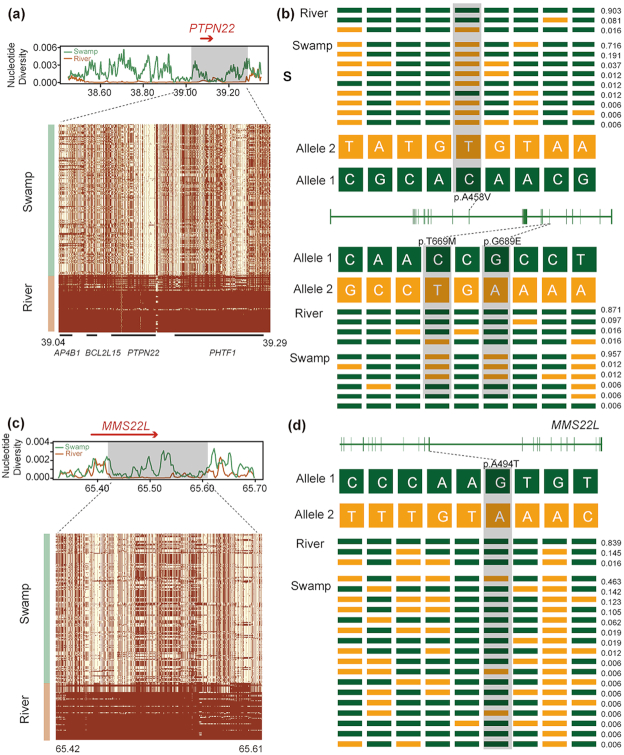
Signatures of selective sweep regions at PTPN22 and MMSL22 genes in river buffalo. Different parameters were estimated for each gene (PTPN22 and MMSL22): nucleotide diversity, degree of haplotype sharing across populations (a and c). A red arrow notes the specific gene region. A schematic structure of each gene (b and d) is also depicted with exons indicated by vertical bars and reference/alternative alleles noted with different colors (green/yellow) and combined to form different haplotypes (each with a specific haplotype frequency next to it). Non-synonymous SNPs are highlighted in gray.